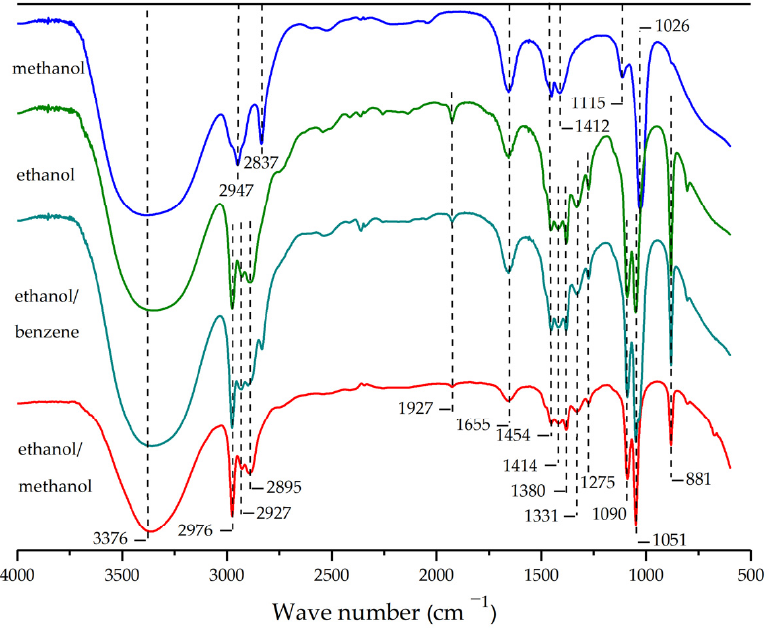
Figure 1. FT–IR spectra of four extract samples of S. holocarpa wood. Methanol, ethanol, ethanol/benzene, and ethanol/methanol extract samples are represented by the blue line, green line, blue-green line, and red line, respectively.